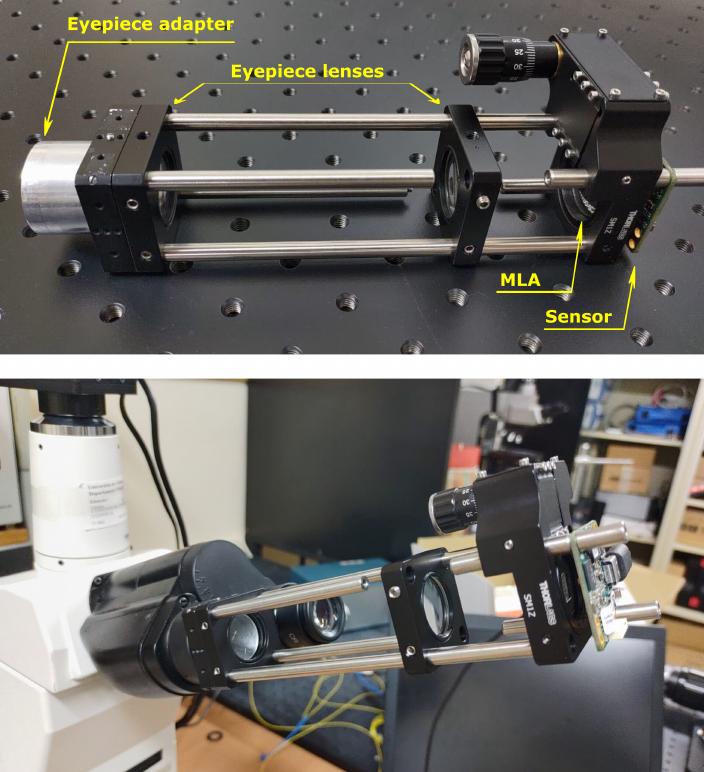
Figure 3. The proof-of-concept device. On the top, the device with all its parts indicated. On the bottom, the device inserted into the